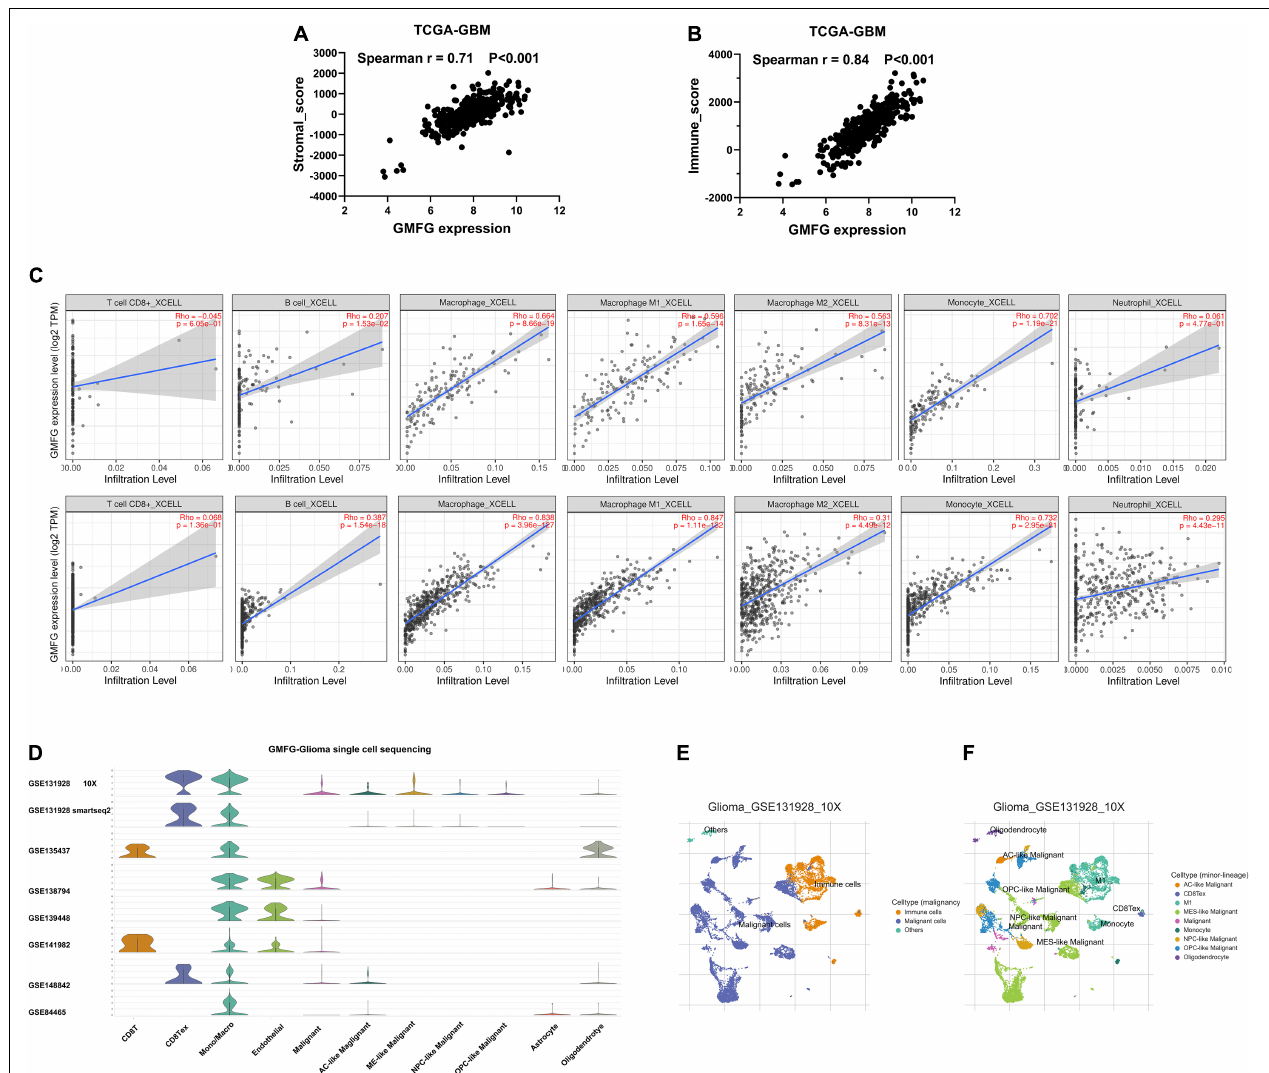
FIGURE 5 | Glia maturation factor- γ correlated with immune cell infiltration in gliomas. Correlations between GMFG expression and stromal score (A) and immune score (B) . Stromal and immune scores were calculated by using the ESTIMATE. (C) Correlation between GMFG expression and the immune infiltration levels in TIMER. (D–F) Gliomas single-cell sequencing datasets from the TISCH database were used to explore the association between GMFG expression and immune cell